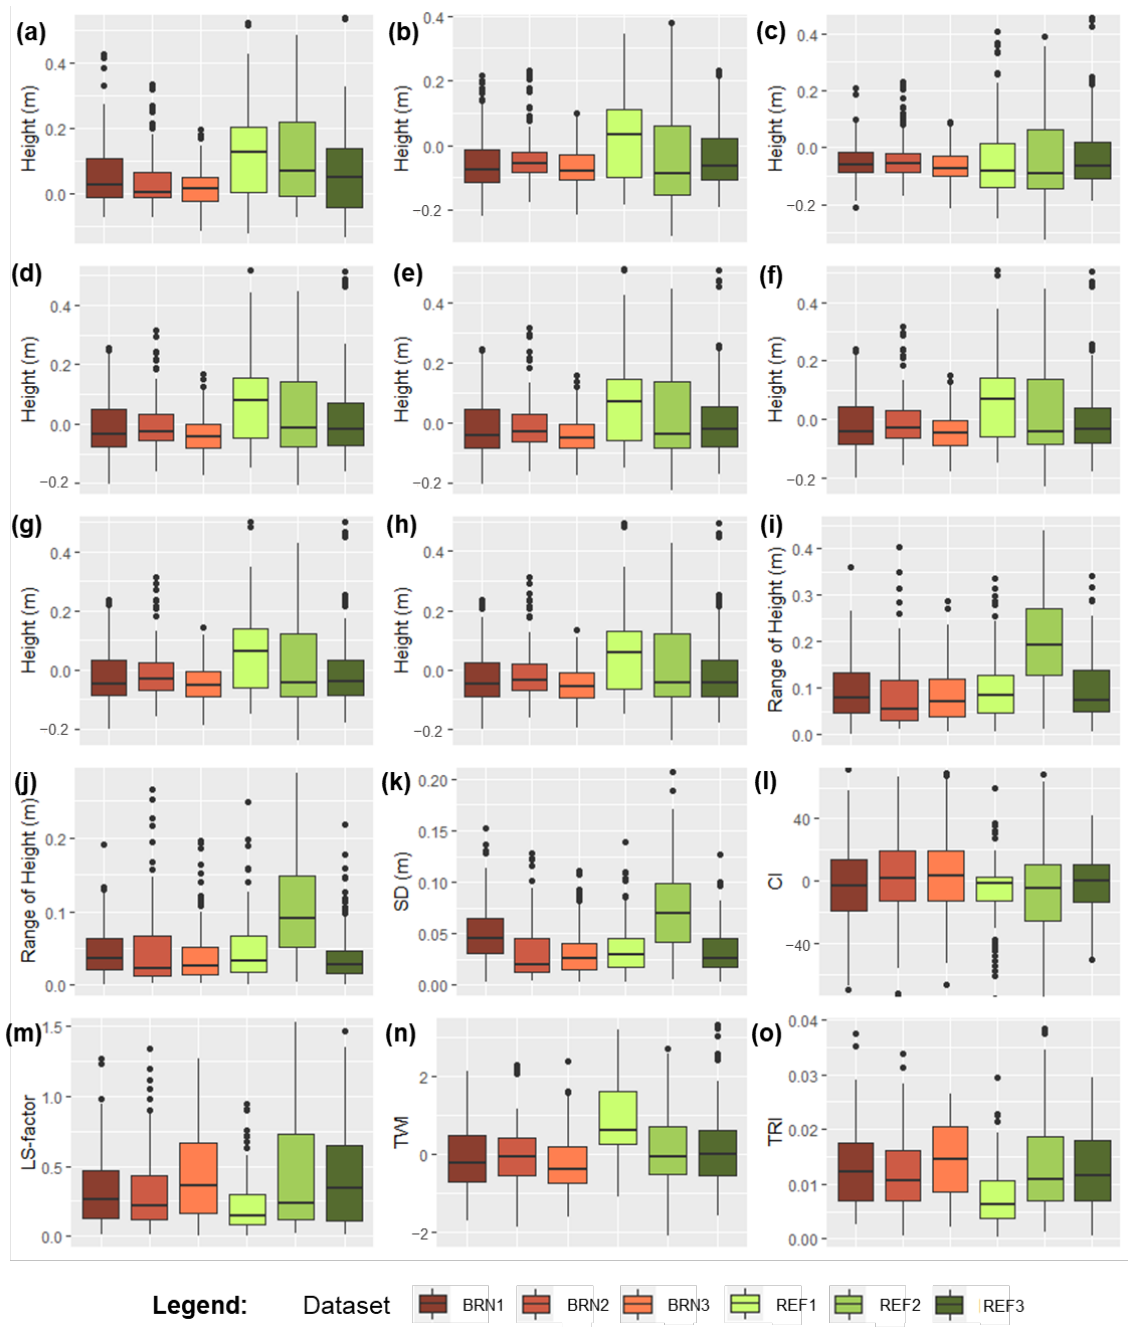
Figure 4. Box plots of the sampled metrics at the BRN (i.e., fire damaged) and REF (i.e., undamaged) sites and different field measurement campaigns; dataset BRN1 contains samples collected on site